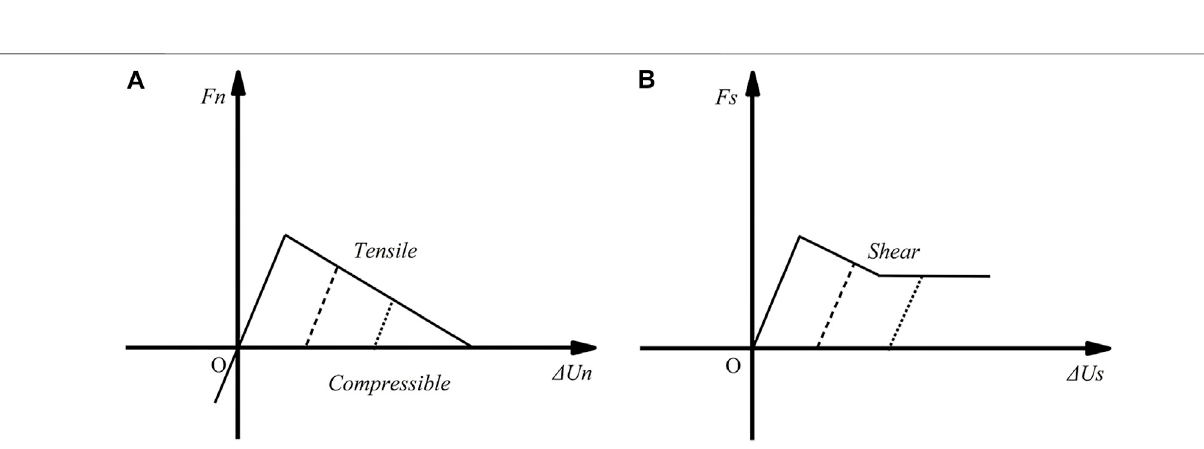
Frontiers in Earth Science |